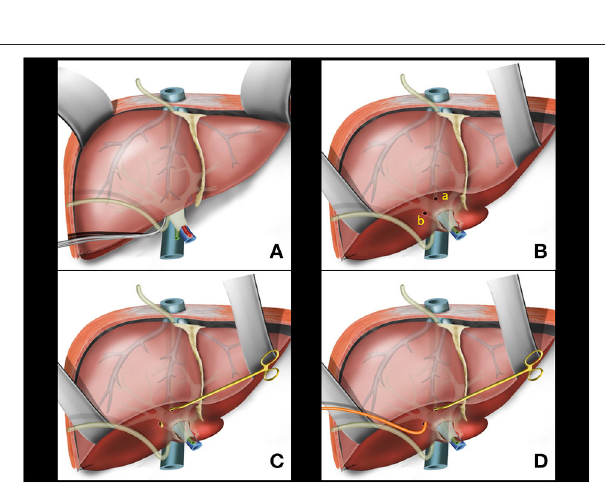
FIGURE 2 | (A) Hanging Liver Maneuver: naso-gastric tube passage in the retrohepatic space. (B) Small openings in the liver capsule at the base of segment 4B (a) and between the right posterior sector and the caudate lobe (b). (C) Glissonian pedicle retriever inserted deep into the liver parenchyma with a rotating movement between previous liver capsule openings. (D) A rubber tube is attached to the instrument